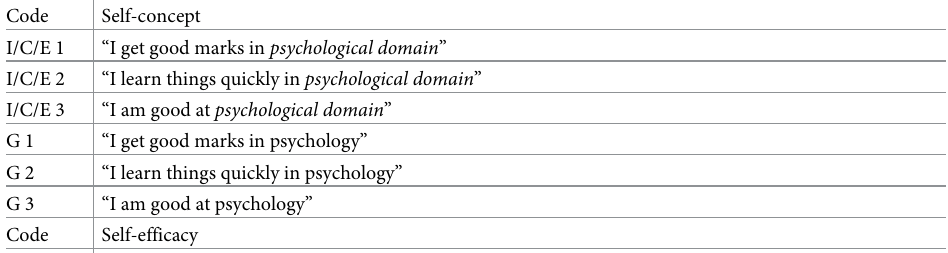
Table 1. Items used for assessing ability self-concept and self-efficacy in psychology